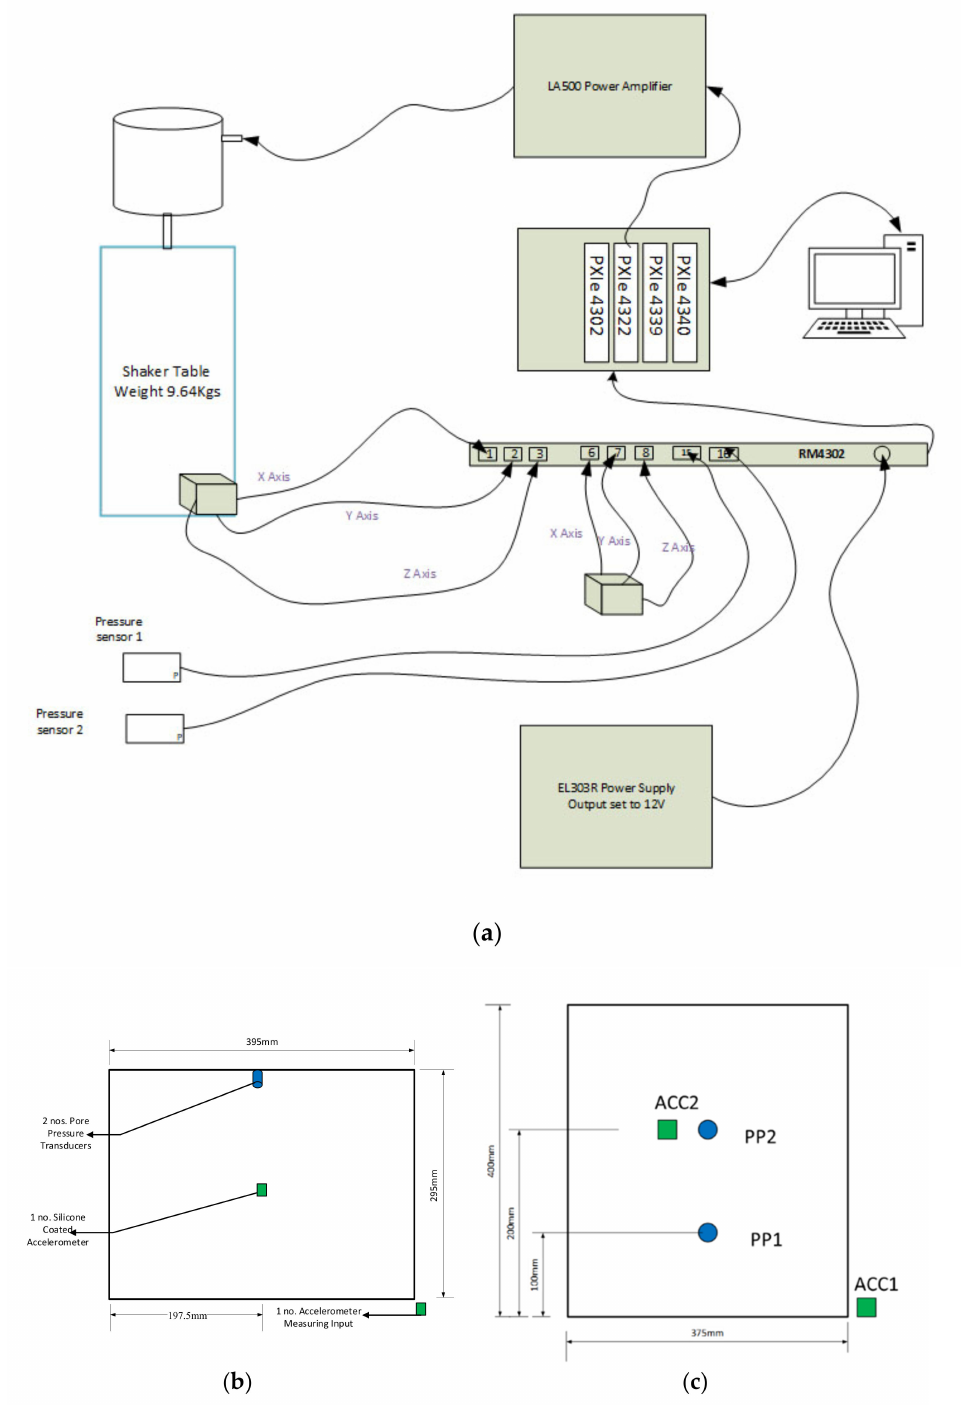
Figure 7. Layouts of the test instrumentation. ( a ) Schematics of the hardware setup. ( b ) Plan view of test instrumentation. ( c ) Side view of test